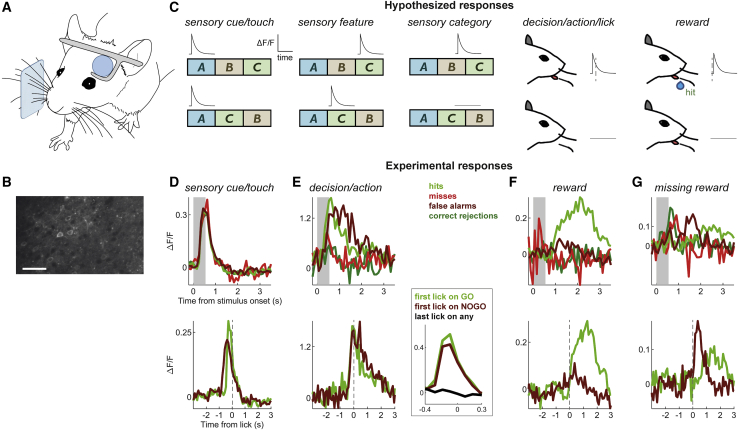
Neuronal Responses in Well-Trained S1bf Reflect Heterogeneous Task Variables and Learned Associations(A) Diagram of experimental setup. Two-photon imaging was carried out while animals performed the task.(B) Example of field of view (scale bar, 100 μm).(C) Hypothetical expected responses to presentation of a target sensory sequence (ABC) and a sequence whose segments’ order has been scrambled (ACB). Diagrams show the ΔF/F0 responses presented by hypothetical neurons reflecting one of the following: sensory cue presentation onset, a specific sensory feature (segment C in the example), sensory category (ABC versus ACB), the prediction of the decision to lick, or the presence of a reward. In the last two cases, note the different timing of the response relative to the lick (dashed line).(D−G) Actual experimental responses. (D) Example neuron responsive to sensory cue. Top, mean ΔF/F0 relative to stimulation time (shaded region: stimulus presentation period). Bottom, mean ΔF/F0 relative to first lick (dashed line). (E) Example neurons predictive of licking. Left panels, one neuron; right panel, different neuron highlighting the difference between responses to first and last licks. Note that peak response precedes licking for both neurons. (F) Example neuron responsive to reward on hit trials. Note that peak only builds up after the end of stimulation and once the lick is over. (G) Example neuron responsive to the absence of a reward on false alarm trials.See also Figure S3.